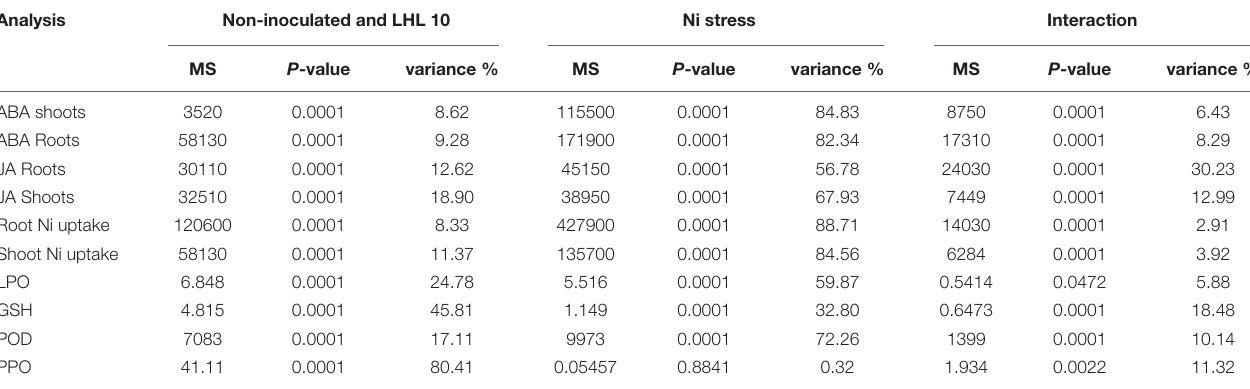
TABLE 3 | Two-way ANOVA table of the biochemical analysis performed for inoculated and non-inoculated soybean under different concentration of Ni toxicity. Analysis Non-inoculated and LHL 10 Ni stress